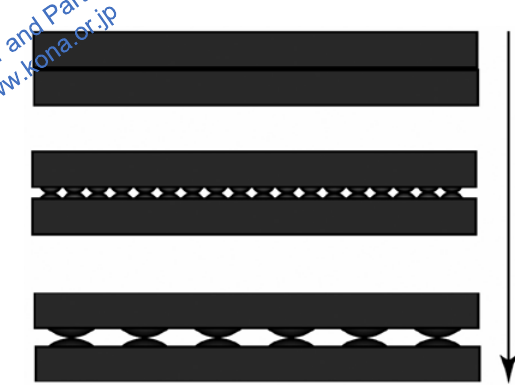
Change in contact area with increasing roughness. The illustra- tion shows the decrease in contact area that occurs with increas- ing surface roughness and is attributed to the difference in inter- particle forces between smooth and rough surfaces.